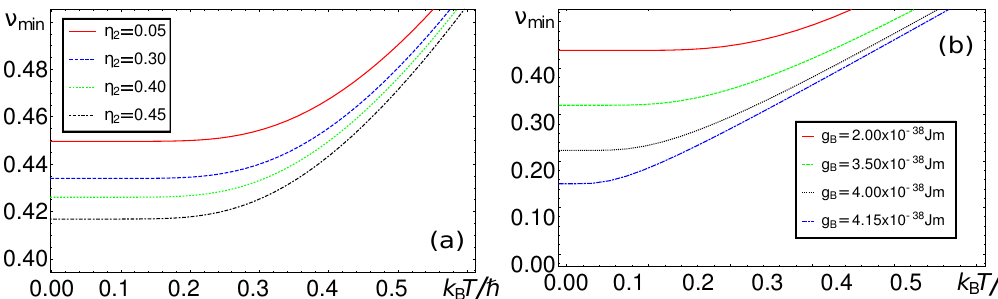
Figure 2: Temperature dependence of the squeezing between the two kinds of trapped impurities . In (a) we study the temperature dependence of squeezing for different = 2.36 · 10 − 38 J · m and in (b) for different values of g values of η with g with 2 B B η = 0.295. In both cases we use impurities of potassium K in a bath of particles of 2 = 600 π Hz , Ω = 450 π Hz , n = 90 ( µ m ) − 1 , η = 0.325 Rubidium Rb and we set: Ω 1 2 0 1 / a = and R 12 HO